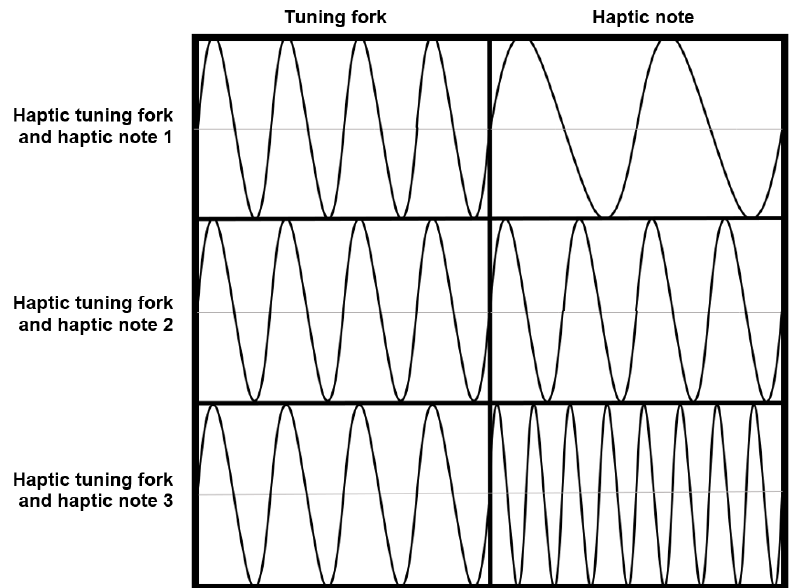
Figure 1. Example of haptic icons. Our haptic icons consist of two signals: a fixed reference signal (the haptic tuning fork) and a signal that codifies the abstract information (haptic note). Since we are testing the idea of using a reference signal in kinesthetic devices, they are rendered as displacement applied to the proxy position in the surface-normal direction. This displacement is shown in the y-axis, while the x-axis represents 2 s. The first second is used to render a 4 Hz haptic tuning fork and then the haptic note. Please, note that the values of the haptic notes have been simplified to 2, 4, and 8 Hz to make the figure clearer. Those values do not correspond to actual values from our frequency-based haptic